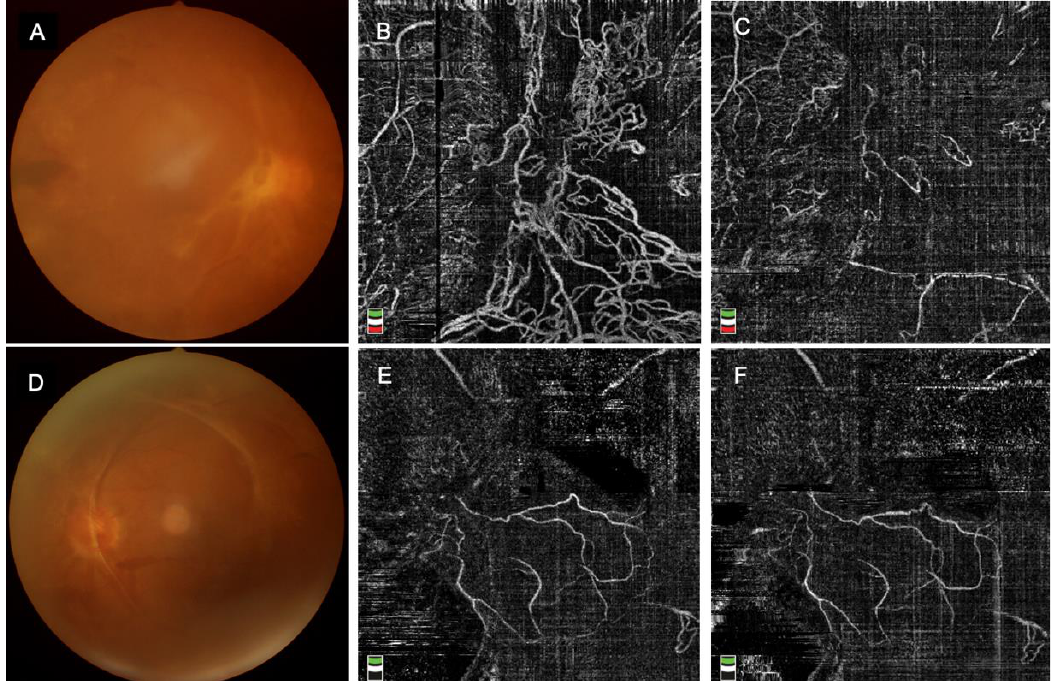
Figure 2. Images of the representative cases with and without IVC, ( A ). Fundus photograph before IVC, ( B ). OCTA image before IVC, ( C ). OCTA image after IVC, ( D ). Fundus photograph in the No-IVC group, ( E , F ). In the No-IVC group, OCTA images scanned at the same time as patients in the IVC